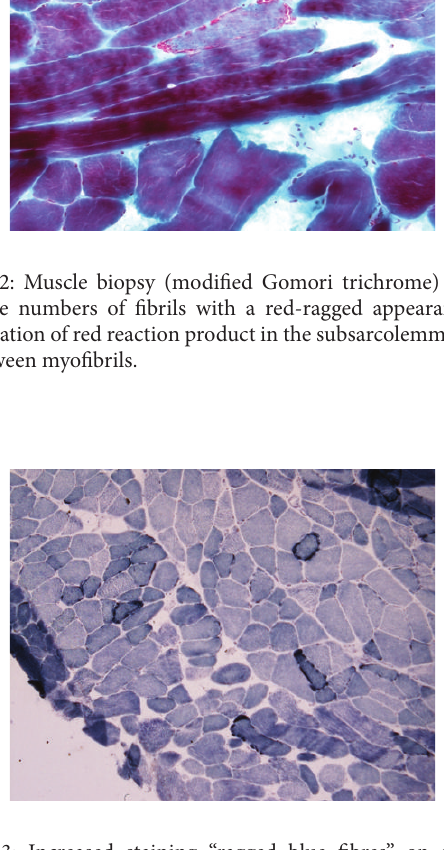
Figure 3: Increased staining “ragged blue fibres” on succinate dehydrogenase